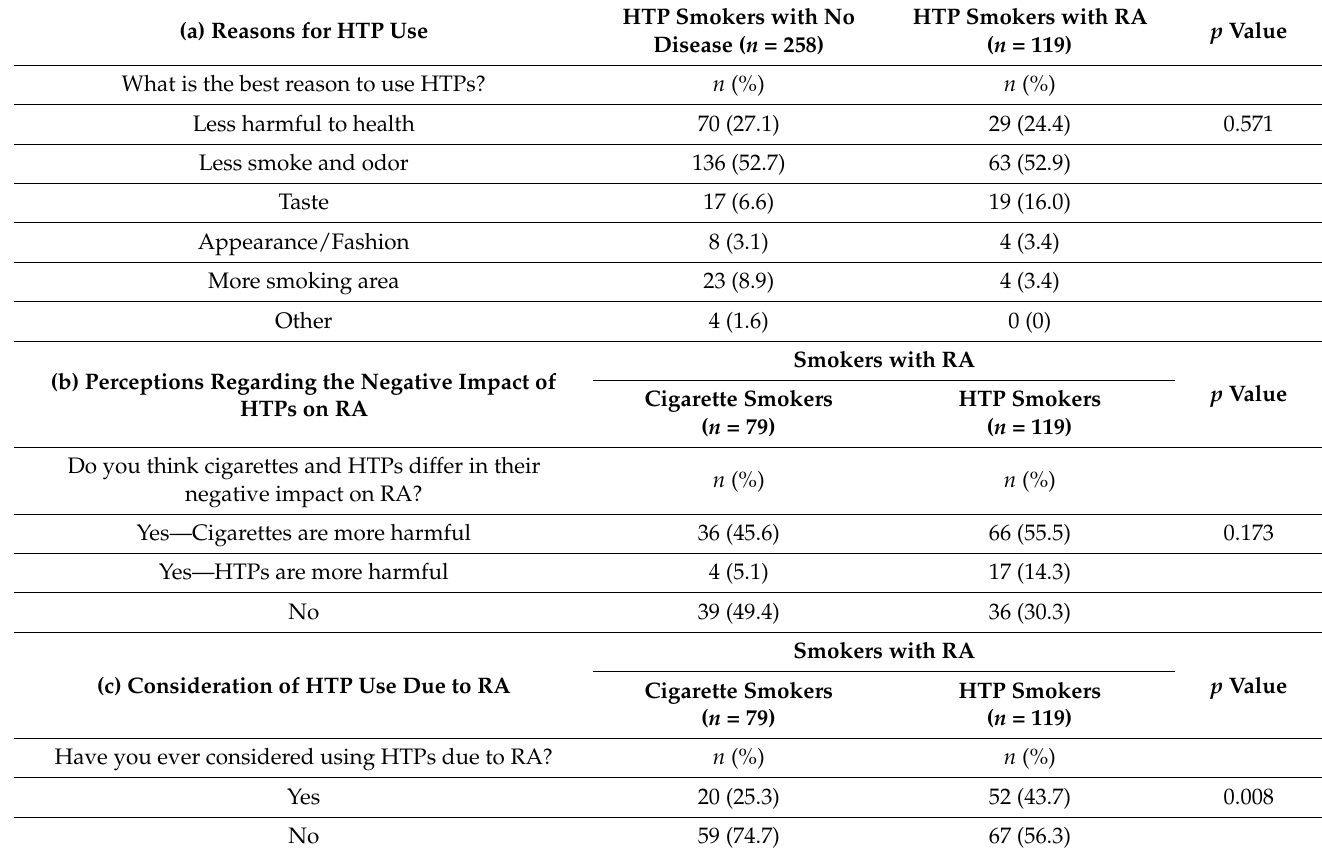
Table 4. Summary of the results of the secondary